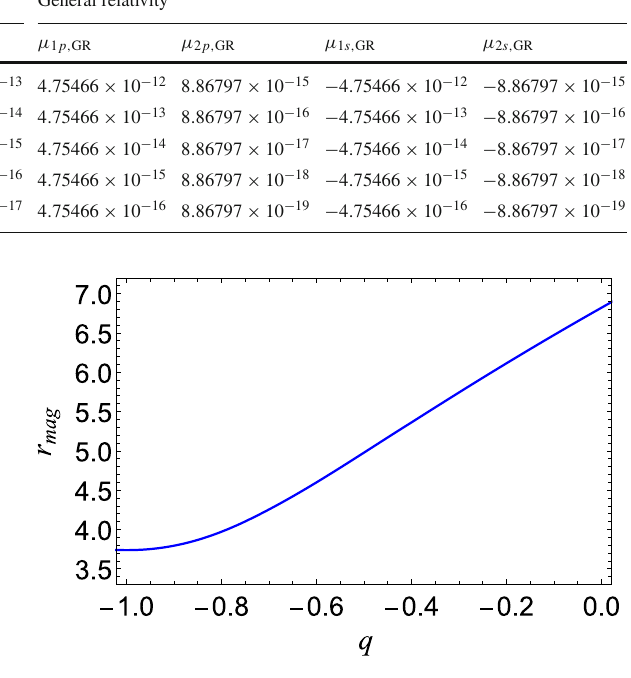
Fig. 8 The behavior of strong lensing observable r mag as function of the parameter q . It is independent of the black holes mass or its distance from the